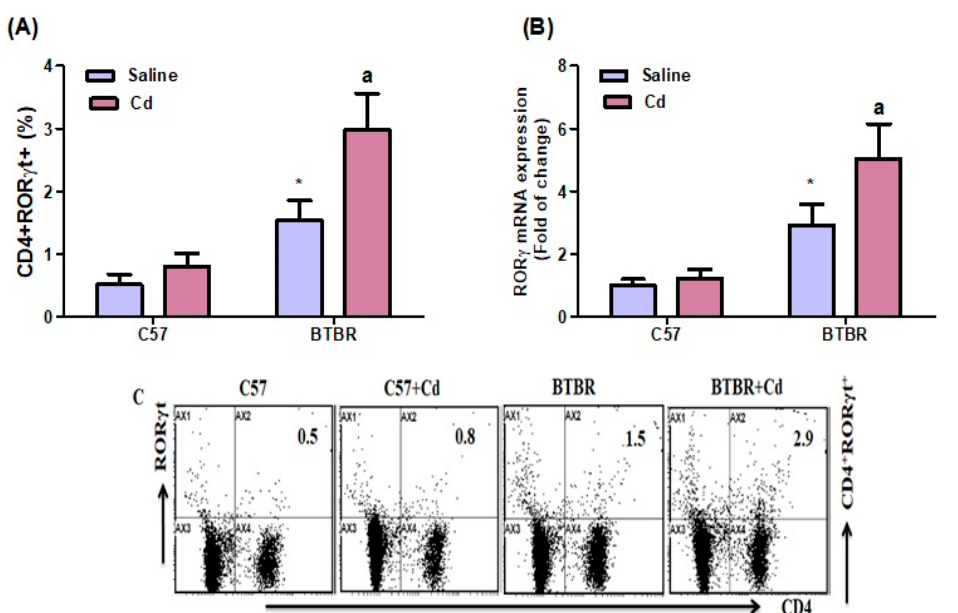
Figure 6. Effects of oral Cd exposure on ROR γ t. ( A ) ROR γ t-expressing CD4 + T cells from the spleen. ( B ) ROR γ mRNA expression in brain tissue. ( C ) Representative FSC-SSC dot plots of CD4 + ROR γ t + cells taken from each mouse spleen. BTBR and C57 mice were orally administered Cd (5 mg/kg/day) or saline only (control) daily for six weeks. All data are shown as mean ± SD ( n = 6/group). Different letter indicate significant difference. * p < 0.05 vs. saline-treated C57 mice, ap < 0.05 vs. saline-treated BTBR mice; two-way ANOVA with Tukey’s test.